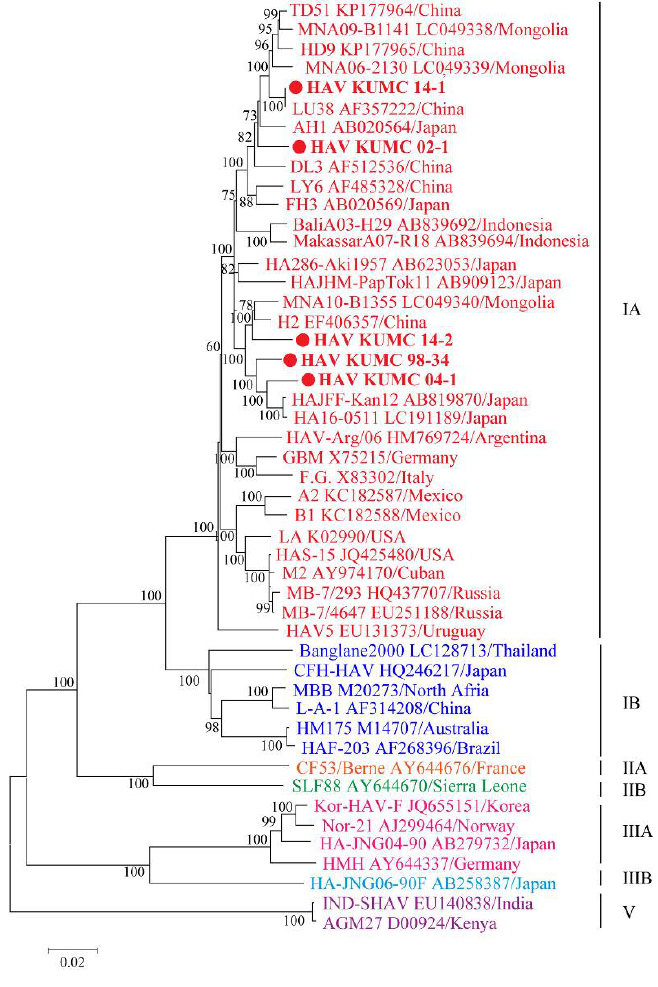
Figure 2. Phylogenetic analysis of the nearly whole-genome hepatitis A virus (HAV) sequences in the Republic of Korea (ROK). Nearly whole-genome sequences of HAV from serum and stool samples were obtained by multiplex polymerase chain reaction-based next-generation sequencing. Branch lengths are proportional to the number of nucleotide substitutions. Vertical distances are included for clarity. Phylogenetic trees of HAV were generated by the maximum likelihood method, with 1000 bootstrap iterations. Colored circles indicate specific HAV strains from ROK; red, genotype IA; blue, genotype IB; orange, genotype IIA; green, genotype IIB; pink, genotype IIIA; sky blue, genotype IIIB; and violet, genotype V.